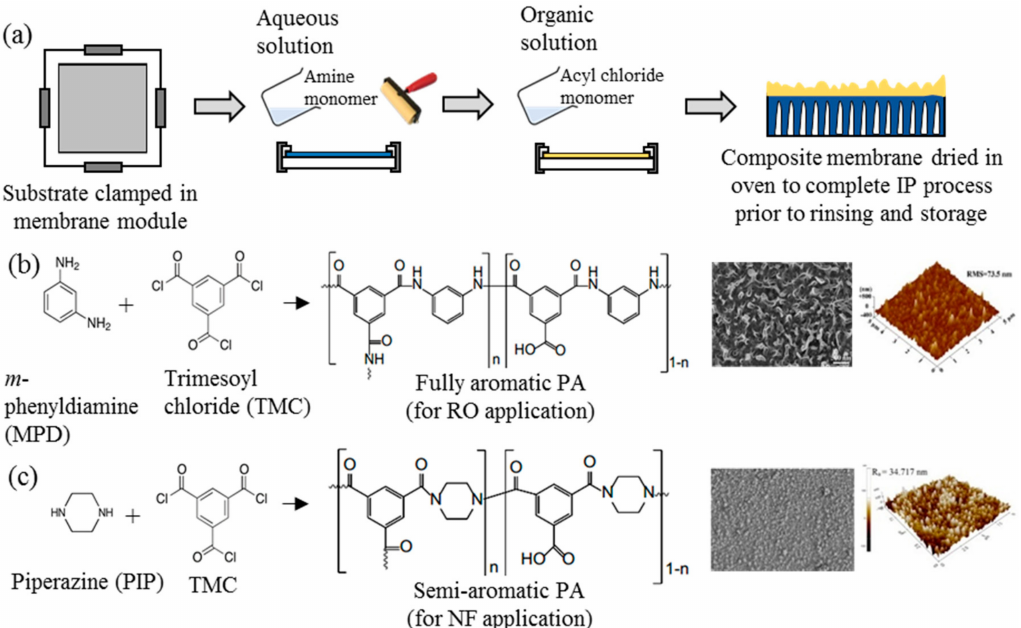
Figure 2. ( a ) Typical lab-scale polymerization (IP) process for TFC flat sheet membrane fabrication and ( b , c ) the two most common crosslinked polyamide (PA) structures for commercial TFC nanofiltration (NF) and reverse osmosis (RO) membranes and their respective FESEM and AFM surface images